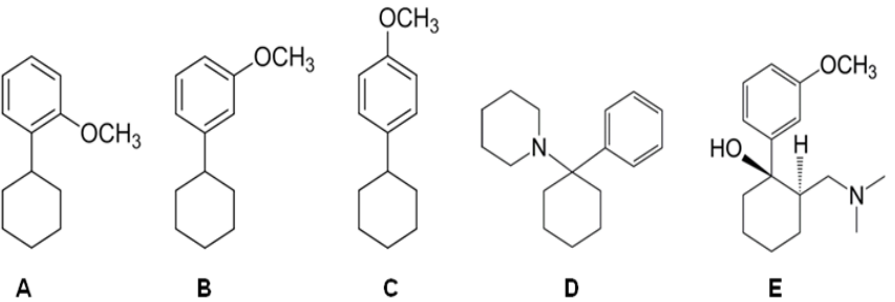
Figure 1. Chemical structures of ( A ) 1-cyclohexyl-2-methoxybenzene (ortho), ( B ) 1-cyclohexyl-3- methoxybenzene (meta), ( C ) 1-cyclohexyl-4-methoxybenzene (para), ( D ) phencyclidine (PCP) and ( E ) tramadol.